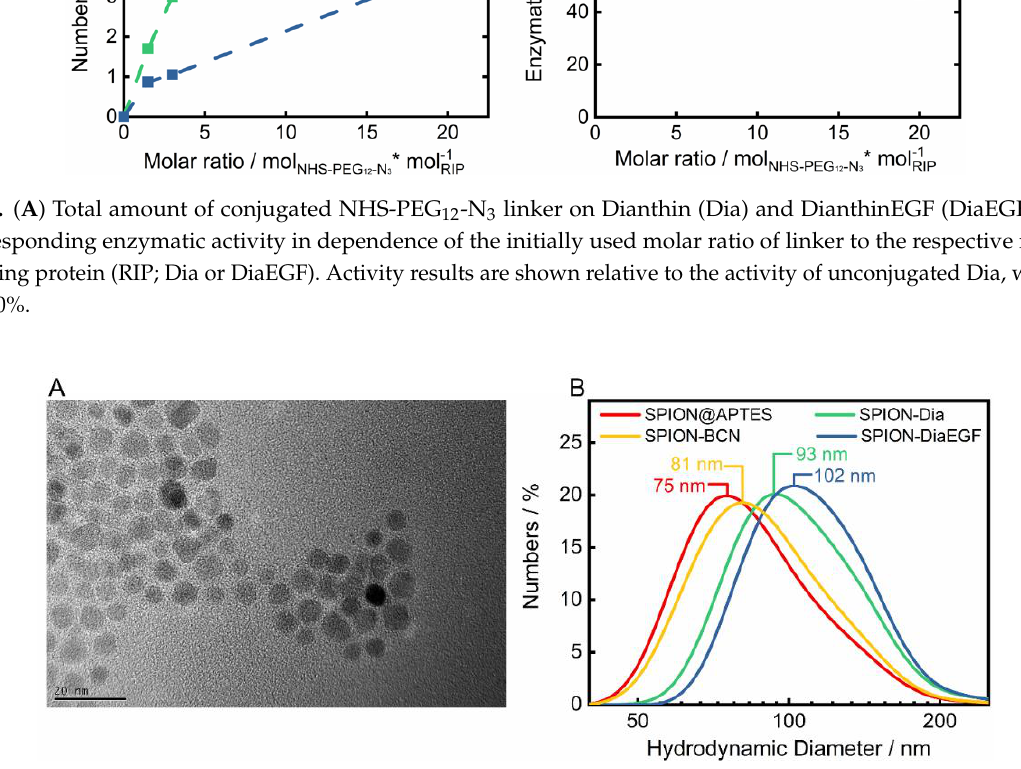
Figure 3. ( A ) Representative TEM image of SPION@APTES and ( B ) dynamic light scattering (DLS) results including the respective median sizes. respective median